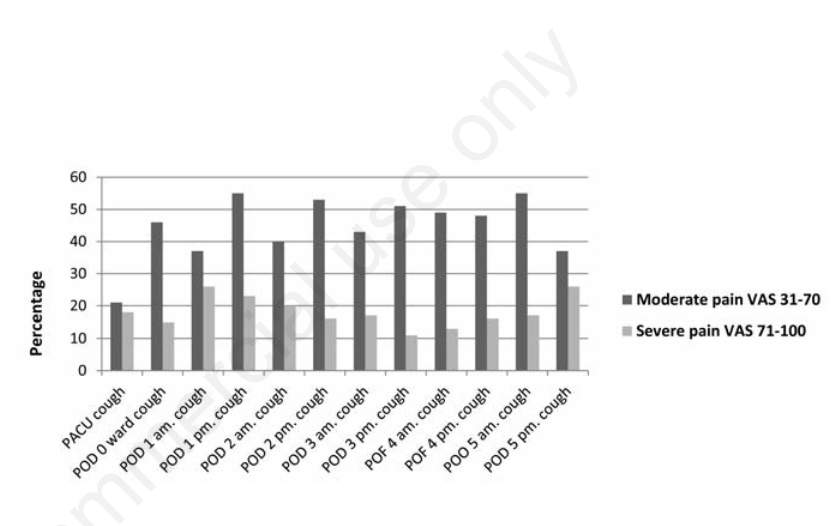
Figure 2. Percent of patients, in the total group, with moderate and severe pain, when coughing, during their hospital stay. Post-operative day (POD) 0-2, n=51; POD 3, n=47; POD 4, n=36; POD 5, n=25. VAS, visual analogue scale.